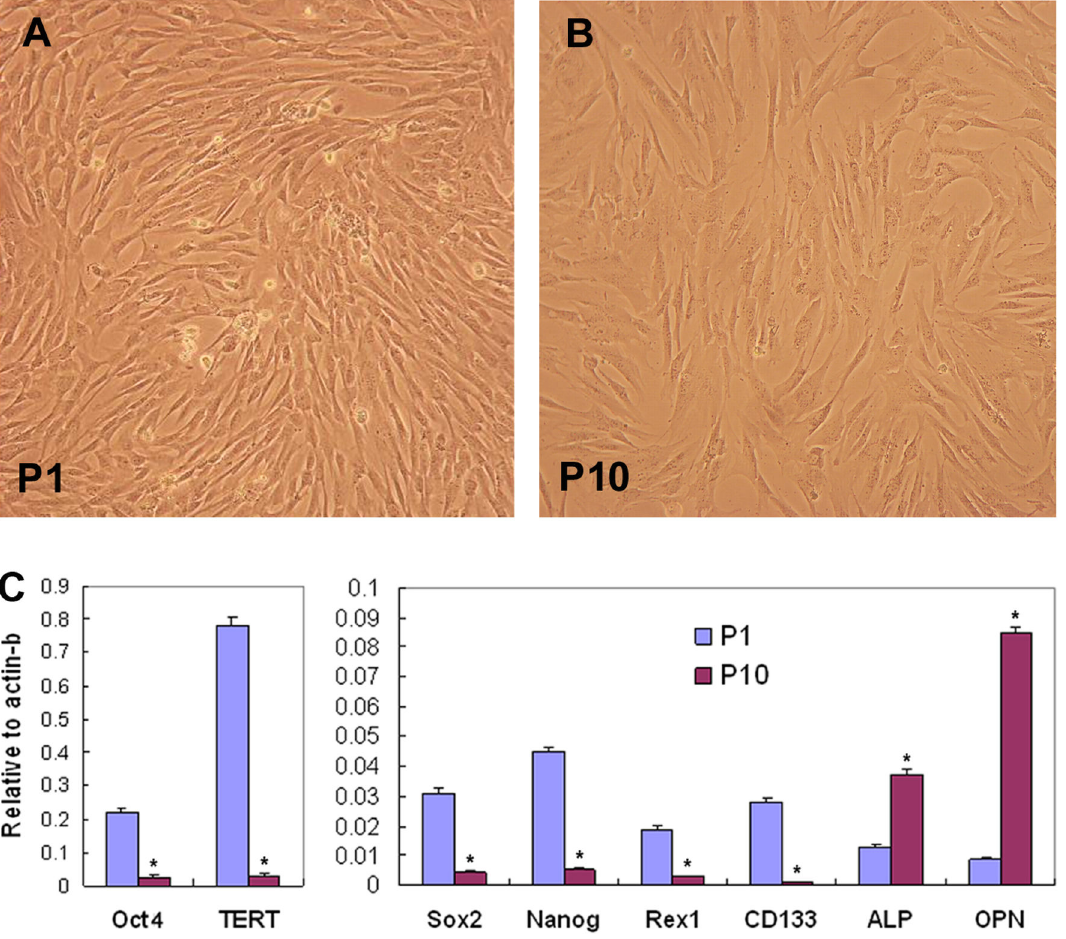
Figure 1. Changes of MSCs in culture. Cultured in growth medium, MSCs in passage (P) 10 were larger and fatter compared to cells in P1 (A & B). Real-Time PCR analysis showed expressional changes of genes involved in stem cell pluripotency and osteogenic differentiation (C). The experiment was repeated three time with similar results, and representative results from one experiment were shown (* P <0.01). ALP, asalkaline phosphatase; OPN, osteopontin. doi: